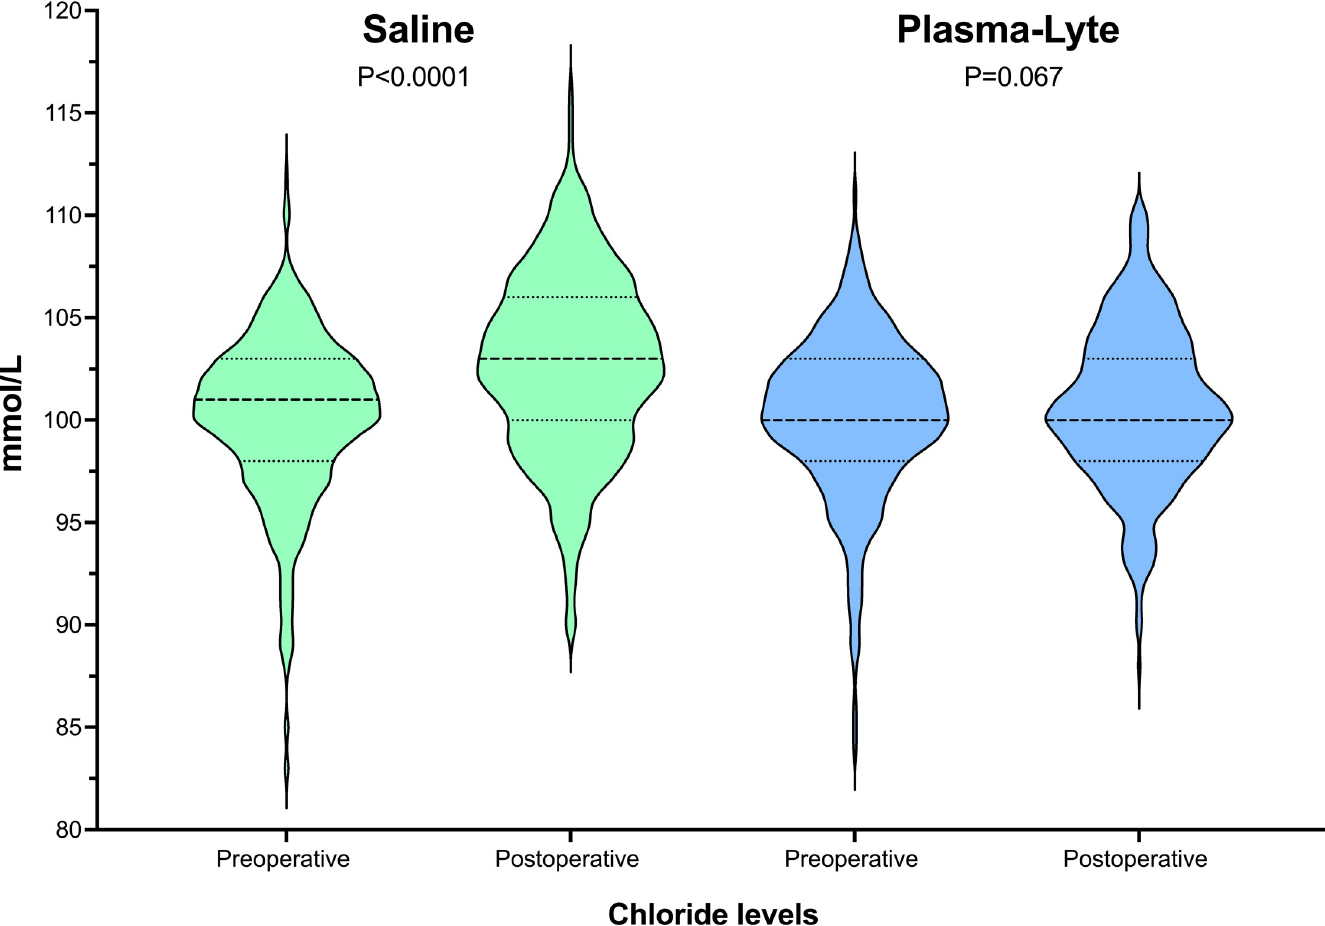
Fig 3. Preoperative and postoperative changes in chloride levels. The single thicker dashed lines represents the median value, and the thinner dashed lines represent the interquartile ranges.